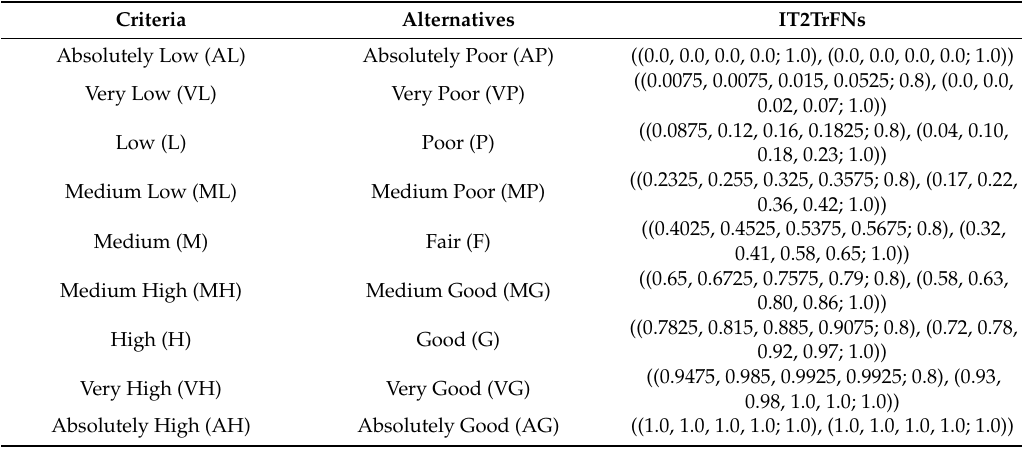
Table 2. Linguistic Choices for Criteria and Alternatives.